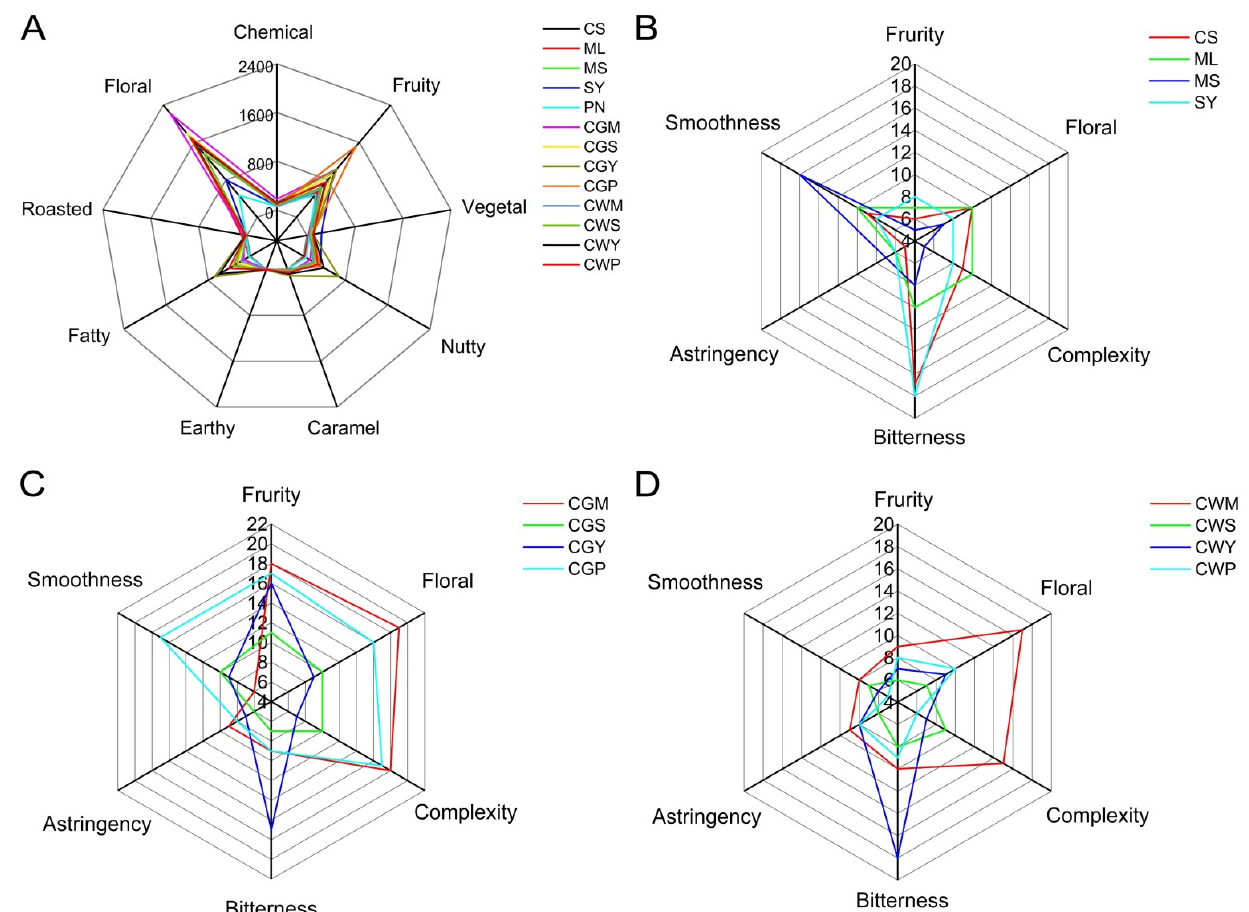
Figure 10. Description of aroma series of wine samples ( A ). The sensory analysis of Monovarietal wines ( B ). The sensory analysis of wine samples with co ‐ grapes treatment ( C ). The sensory analysis of wine samples with co ‐ wines treatment ( D ).